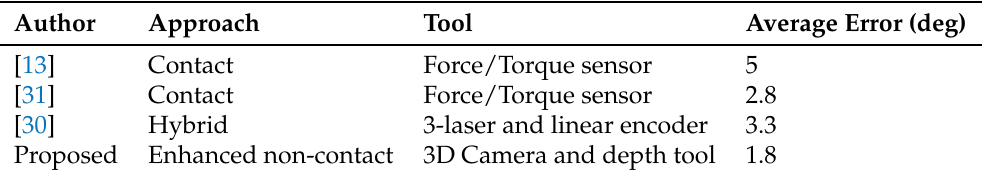
Table 1. A comparative study of the proposed work and earlier research efforts.